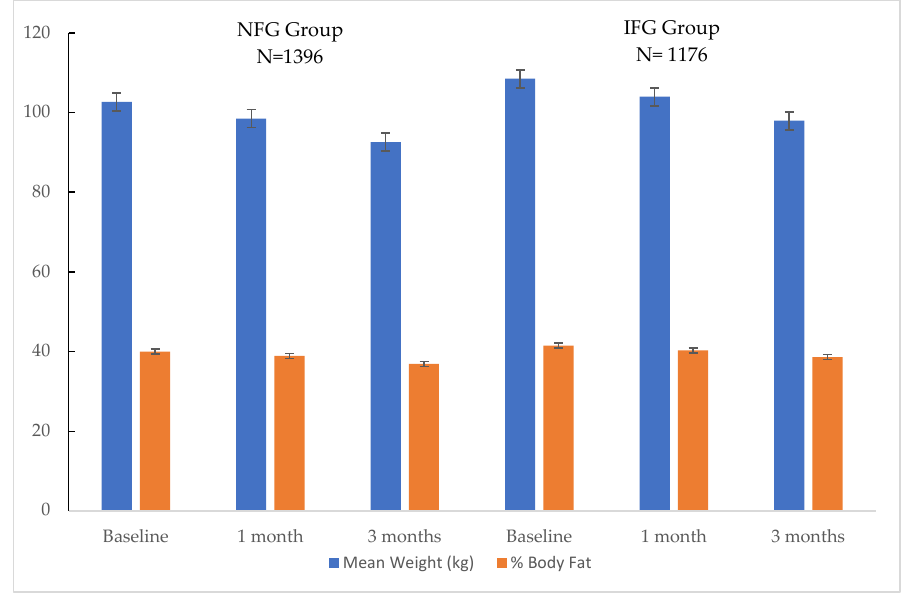
Figure 2. Change in weight (kg) and body fat (%) over the 3 months. Mean ± standard error. Dark blue bar: body weight. Orange bar: body fat.